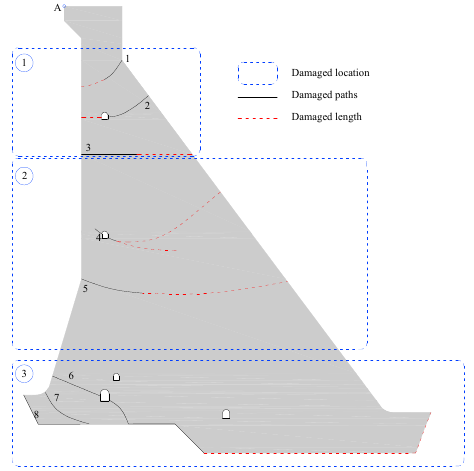
Figure 3. Typical damage modes of the Guandi gravity dam.